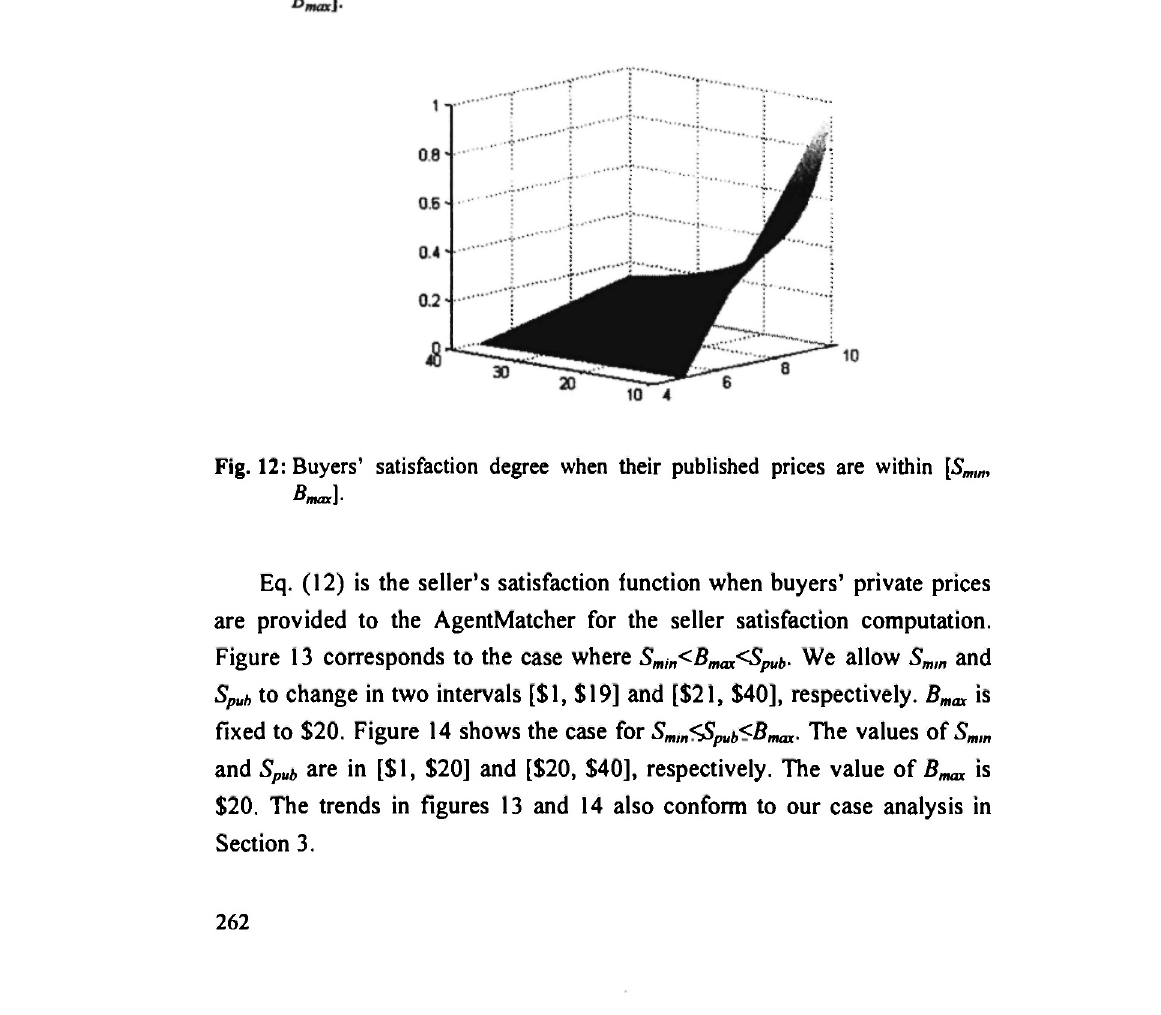
Fig. 11: Buyers' satisfaction degree when their published prices are beyond [5,